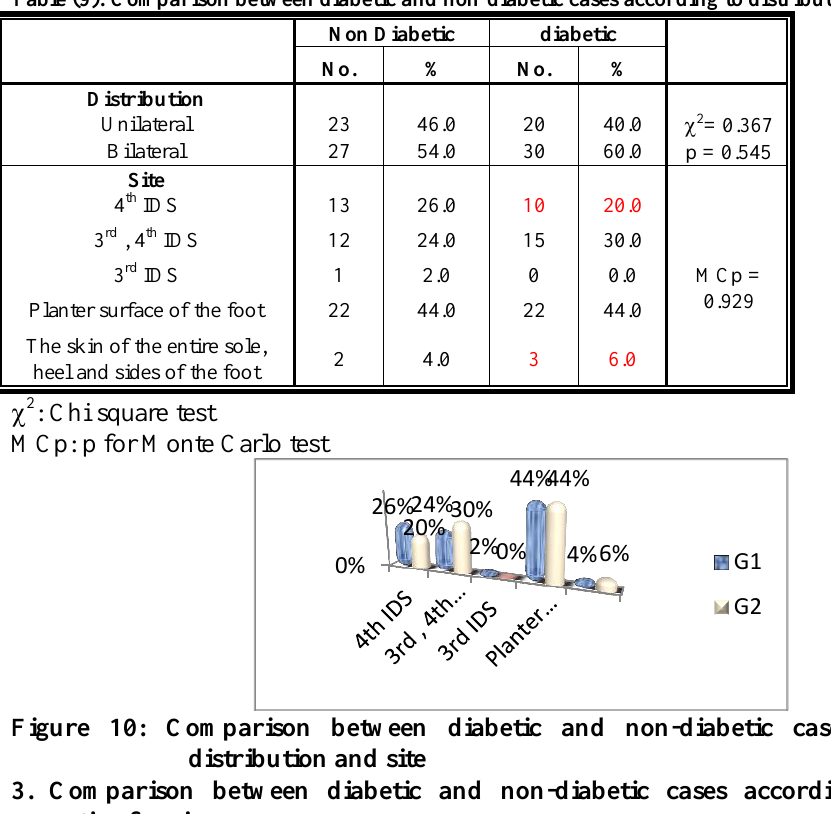
Figure 9: Distribution of the diabetic cases according to diabetic profile 2. Comparison between diabetic and non-diabetic cases according to distribution and site: